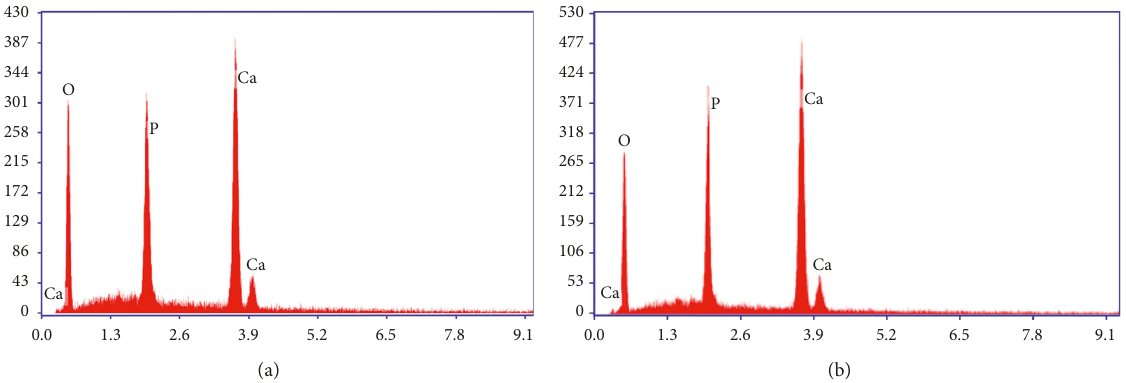
Figure 5: EDX spectra of H